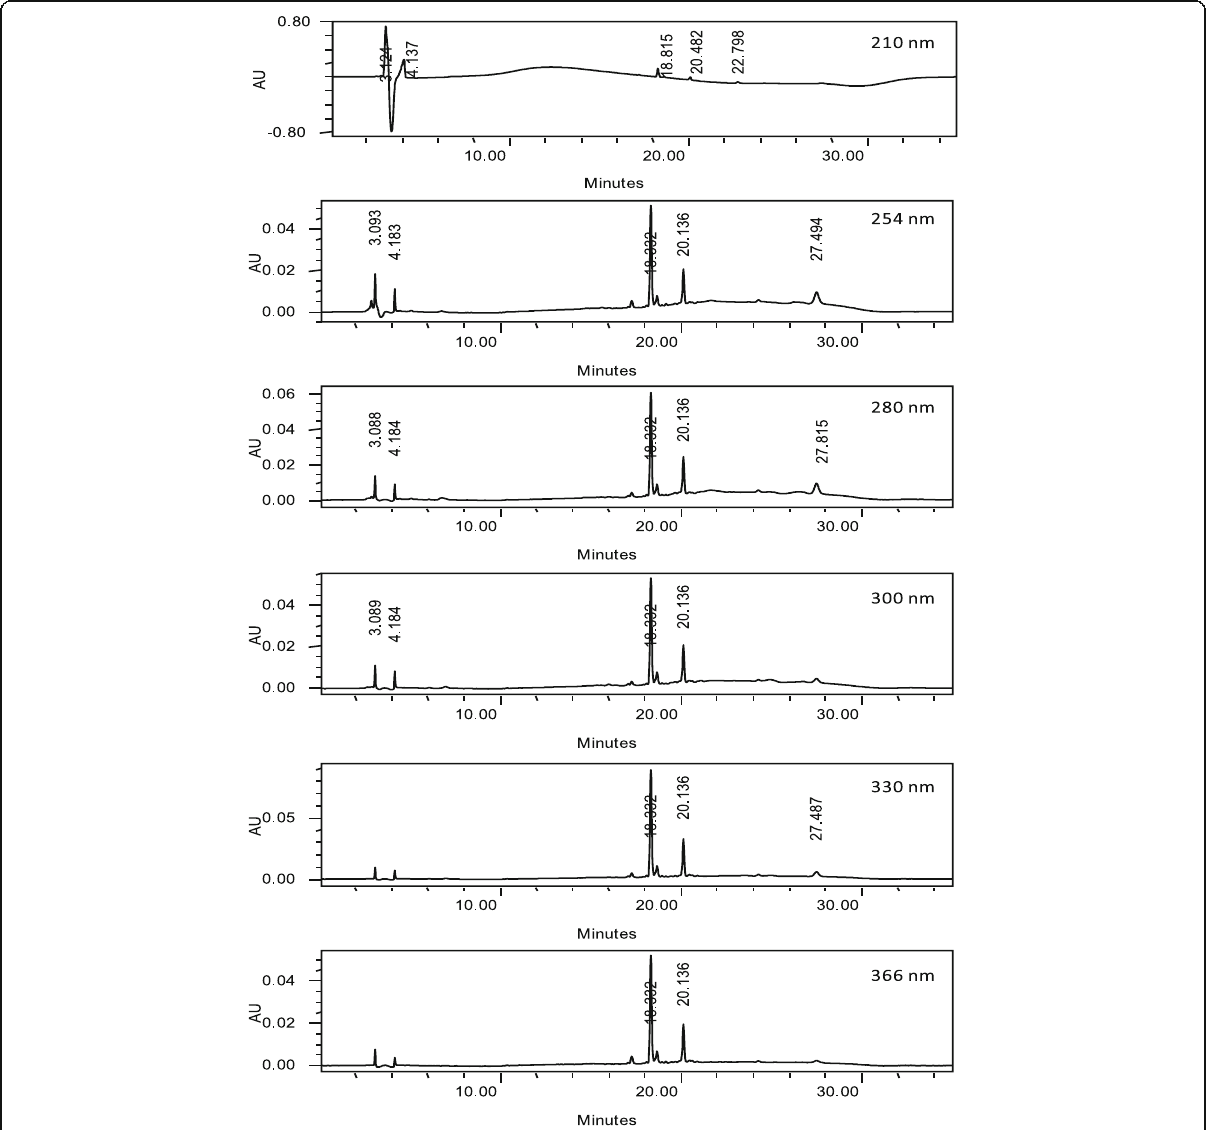
Fig. 6 The HPLC profile of PECN at the wavelengths of 210, 254, 280, 300, 330 and 366